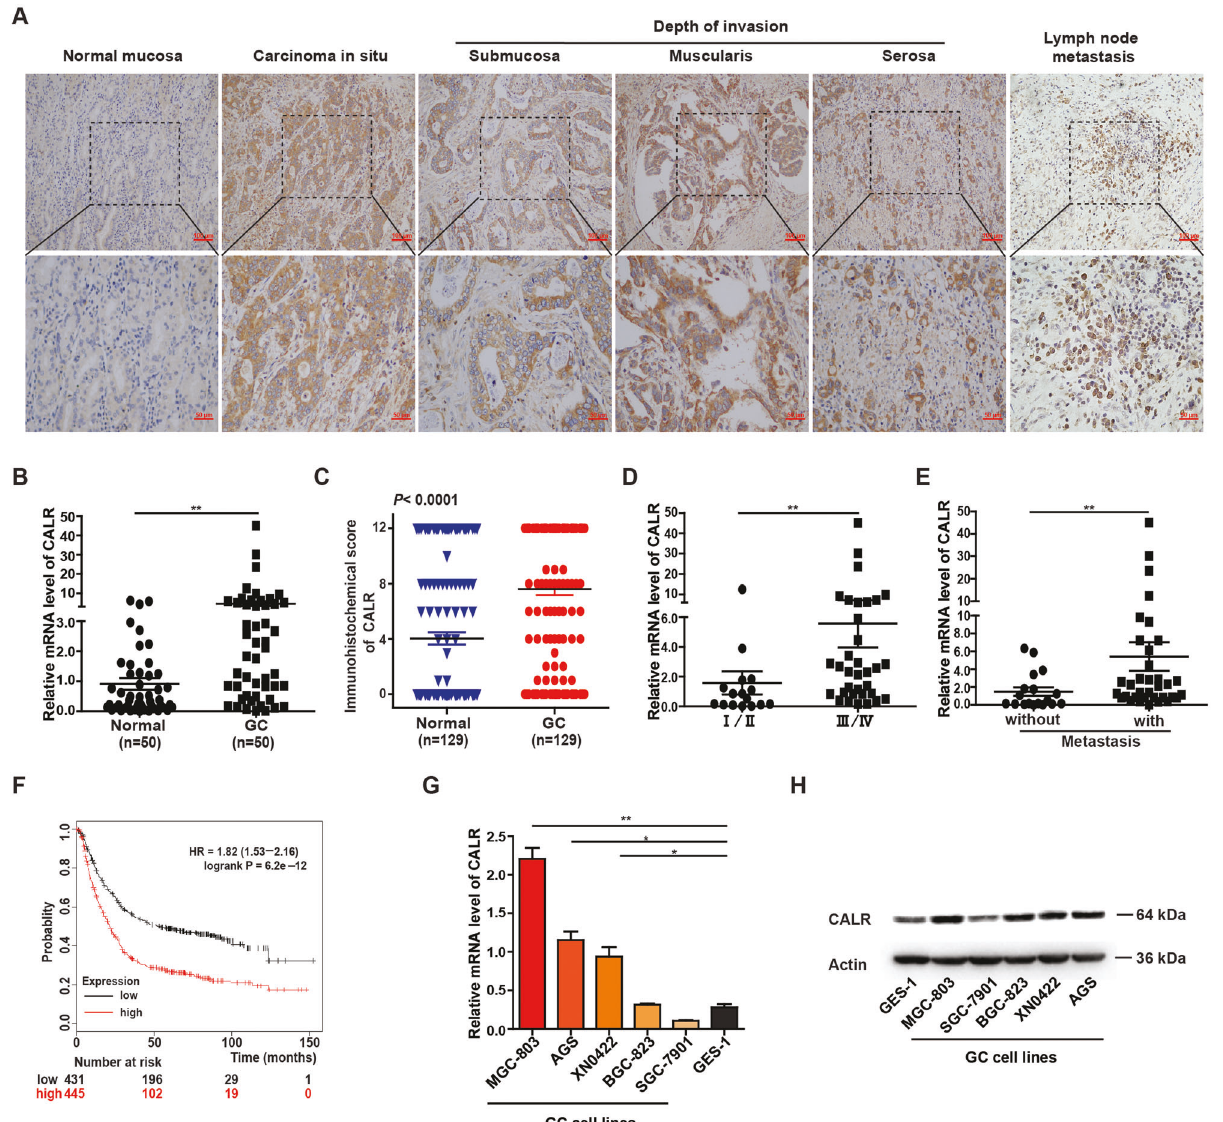
Fig. 1 The level and characteristics of CALR in GC tissues or cells. A Representative IHC staining of CALR in GC tissues, normal tissues and metastatic lymph node (scale bar = 50 μ m). B RT-qPCR data for CALR expression in 50 paired fresh GC and normal tissues. C Scores analyses of the IHC results; n = 129 vs 129. D , E RT-qPCR data for CALR levels by TNM stage (I + II vs. III + IV) and primary GC tissues with or without lymph node metastasis. F Kaplan – Meier analysis of 876 GC patients implyed that high CALR expression was associated with shorter overall survival. G , H the mRNA and protein level of CALR in normal gastric mucosal epithelial cells (GES-1) and the GC cells (SGC-7901, MGC-803, BGC-823, AGS and XN0422). The data are presented as the mean ± SEM. * P < 0.05, ** P < 0.01, *** P <